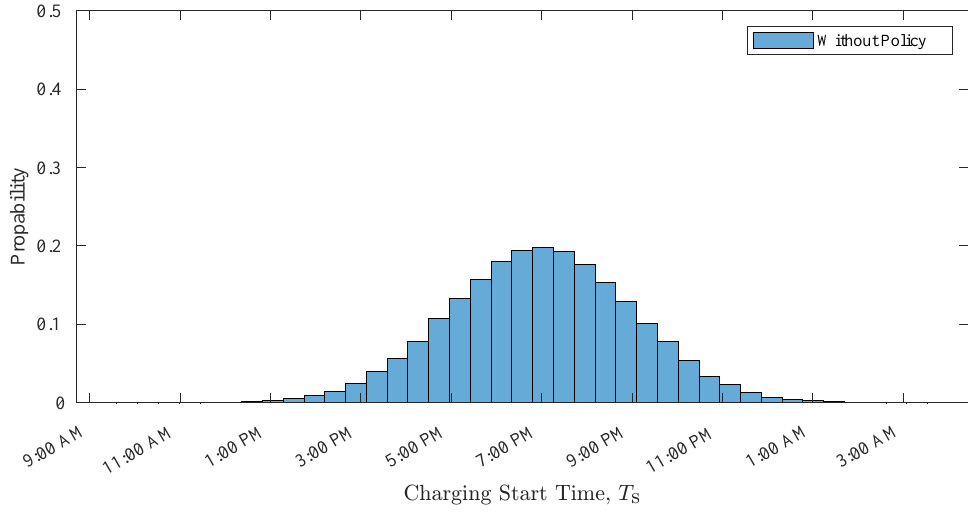
Figure 7. The distribution of the uncontrolled charging starting time, T s